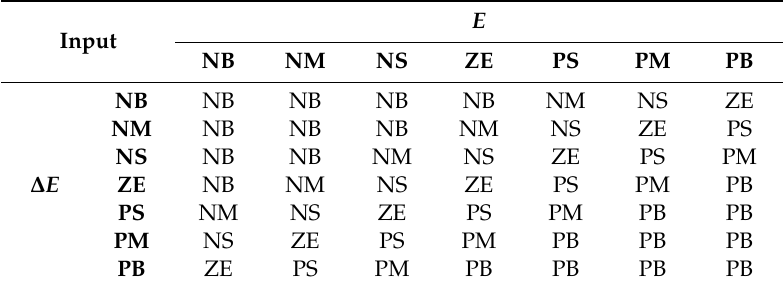
Table 3. Fuzzy logic rules for the voltage source inverter (VSI).